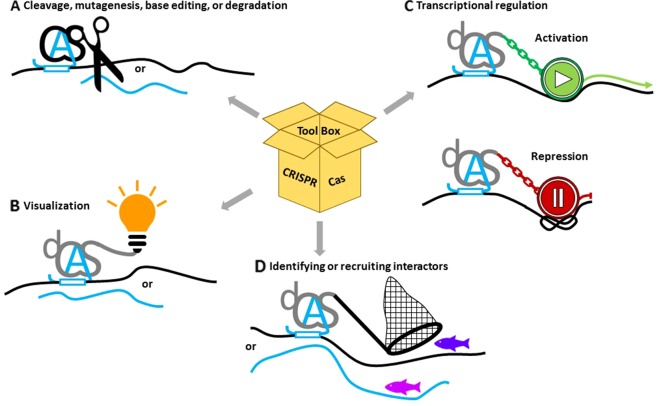
Applications of CRISPR/Cas to study the role of noncoding RNAs. (A) Catalytically active Cas proteins (black) together with guide RNAs (blue A) can induce double- or single-strand lesions or base editing on DNA (black lines) or RNA (blue lines). (B) Nuclease-dead versions of deadCas proteins (dCas) (gray) fused with fluorescent tags or immuno-epitopes can help to visualize specific targets. (C) Fusions with activating or repressing domains or with chromatin-modifying enzymes can change gene expression. (D) Coupling interactive proteins to dCas can assemble additional proteins at the binding site, while binding specificity can be exploited to isolate proteins associated with the site.